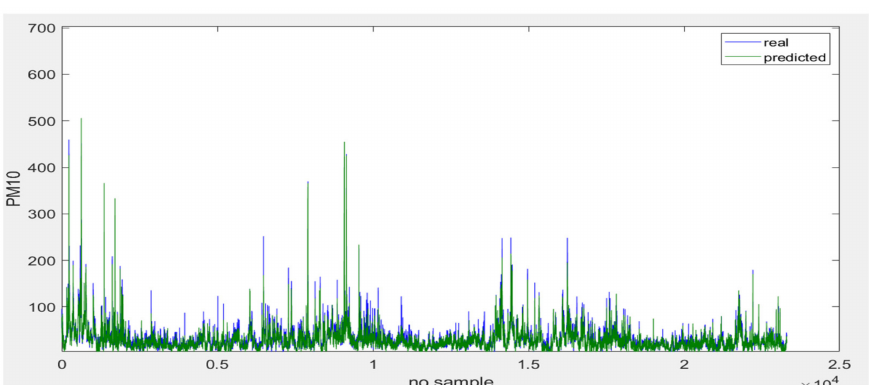
Figure 10. Comparison of the actual data and the data obtained by